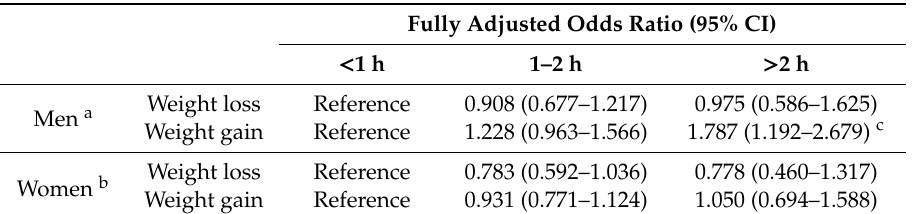
Table 5. Association between social jetlag and body weight